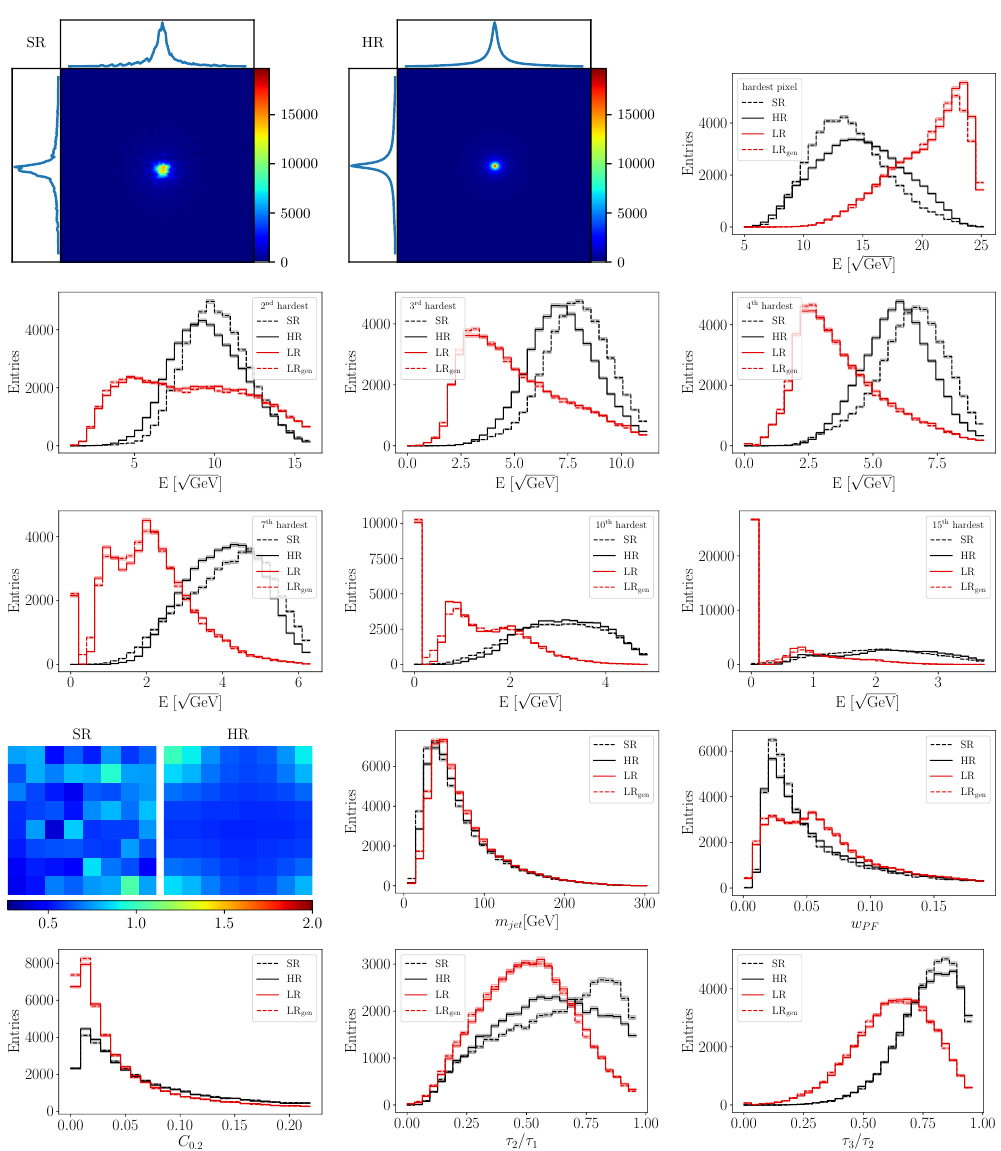
Figure 9: Demonstration of the performance of a network trained on top-quark jets and applied to QCD jets. Top left are averages of the HR and SR images, followed by distributions of the square-root of the energy of leading pixels, sub-leading, etc. Also shown are average ( f × f )-patches for the SR and the HR images, and distributions of high-level jet observables, see text for definitions. The zero-bin in energy collects jets with too few